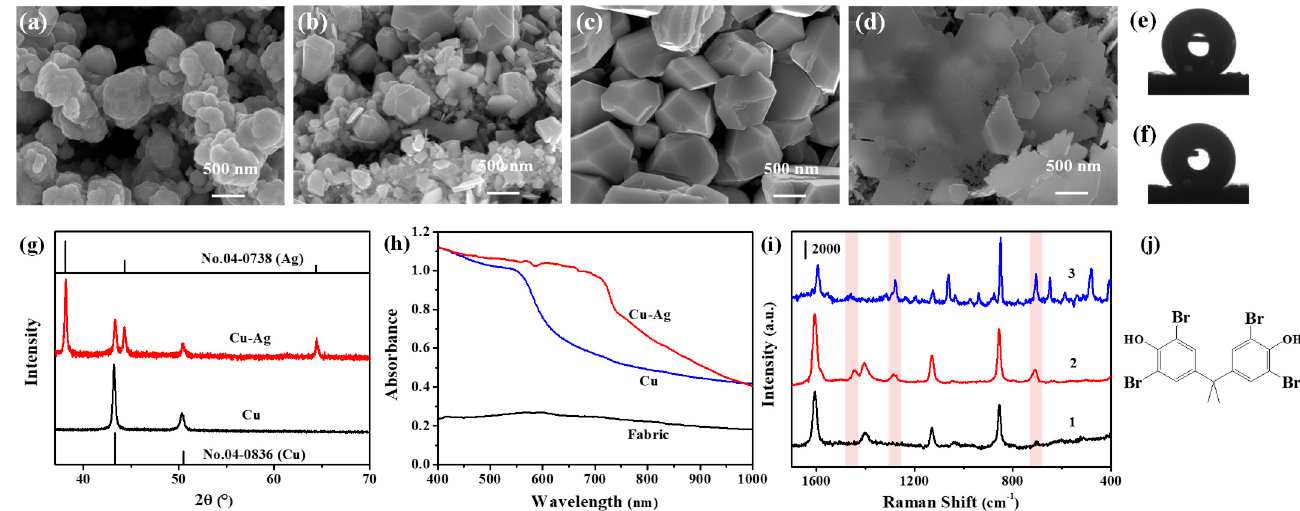
Figure 1. Characterization of Cu-Ag chips and their SERS detection of TBBPA. SEM images of the ( a ) Cu coating with 24 h deposition and ( b – d ) Cu-Ag coating with replacement times of ( b ) 3 min, ( c ) 5 min and ( d ) 10 min. ( e , f ) Contact angles of the coatings of ( e ) 24 h Cu and ( f ) 24 h Cu-5 min Ag on the fabric. ( g ) XRD patterns and ( h ) Vis-NIR diffuse reflectance spectra of the Cu and Cu-Ag chips. ( i ) Comparison between SERS spectra of (1) a blank background, (2) TBBPA solution (10 mg L − 1 ) obtained from the hydrophobic Cu-Ag chips and (3) Raman spectrum of TBBPA powders. ( j ) The molecular structure of TBBPA.